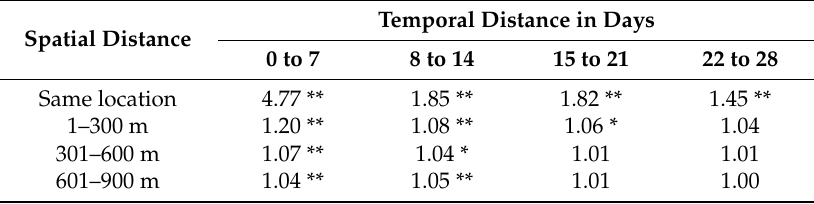
Table 2. Near-repeat risk values (observed over mean expected frequencies) and significance levels of street robbery for the total